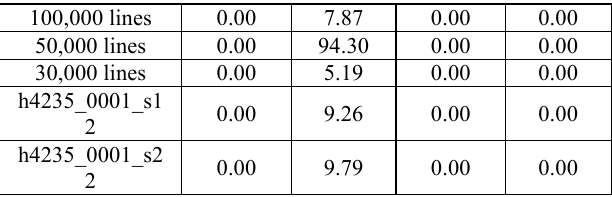
Table 2. Fitting residuals of time-based RFM